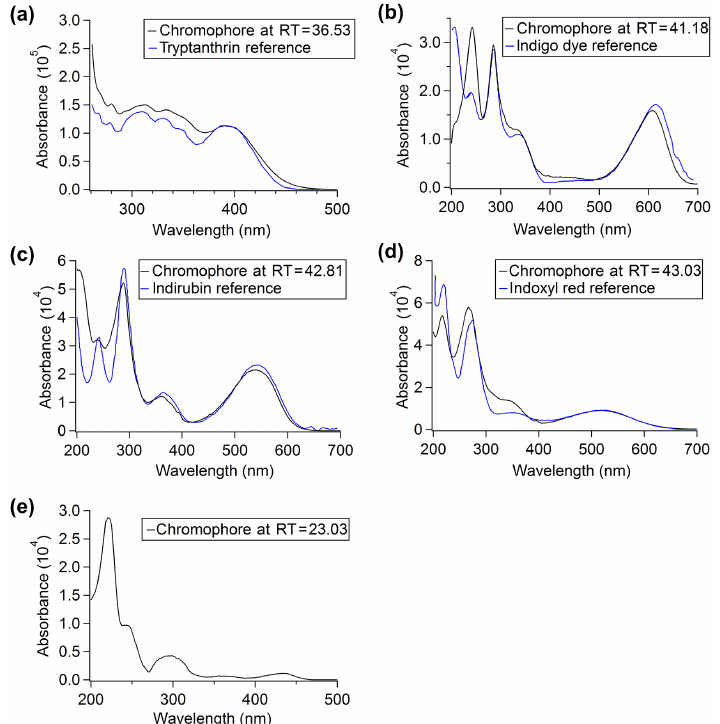
Figure 8. Comparison between measured PDA absorption spectra at selected retention time (RT) and reference spectra of proposed chro- mophores in the literature (reference spectrum is not available for dihydro indigo dye; panel e